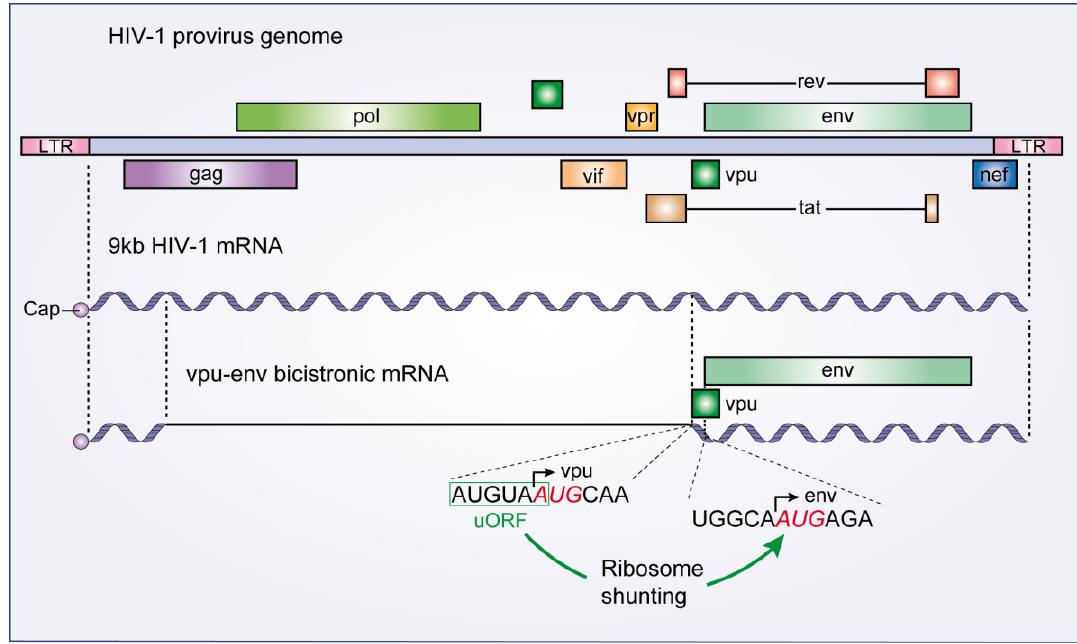
Figure 3. The HIV-1 vpu-env bicistronic mRNA. A schematic diagram of the HIV-1 provirus genome is presented along with its primary 9 kb mRNA transcript. The vpu-env bicistronic mRNA is formed after splicing of the 9 kb mRNA. Start codon sequences of both vpu and env ORFs are presented and the upstream ORF that stimulates Env translation is boxed in